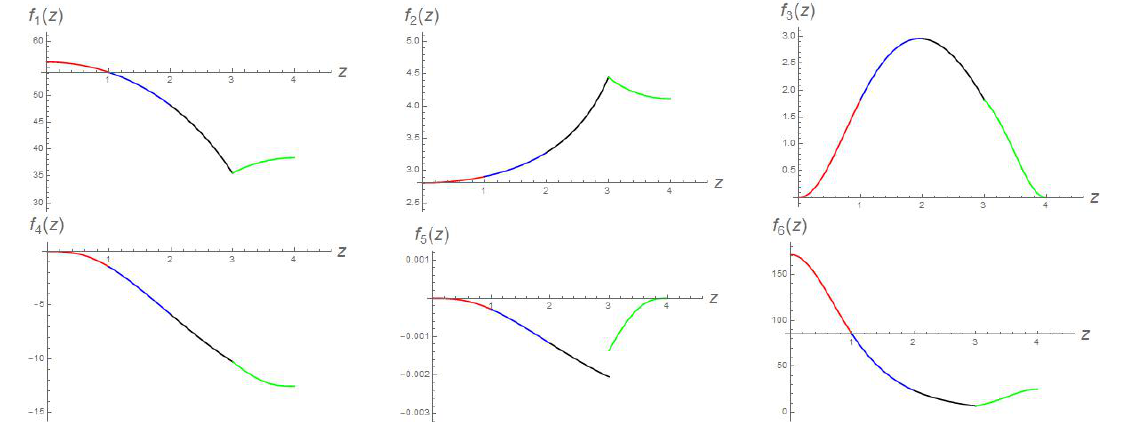
Figure 2. The function ^ (cid:11) ( z ) (cid:17) (cid:11) ( z ) the quiver in (cid:12)gure 1.